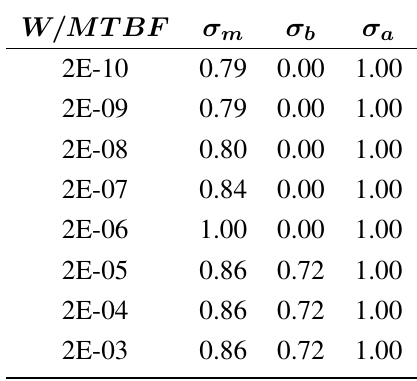
Table 6. Speeds for different task size over MTBF. ρ = 0.5, N = 100,000, t t = 2.6 R 2